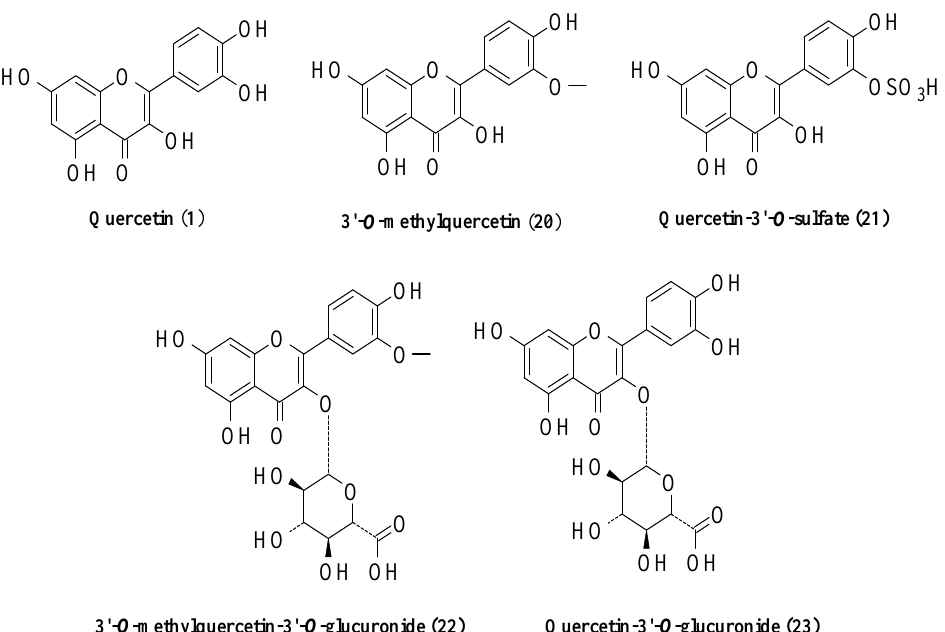
Figure 4. Quercetin and its metabolites inhibited inflammatory eicosanoid production from human leukocytes [29].